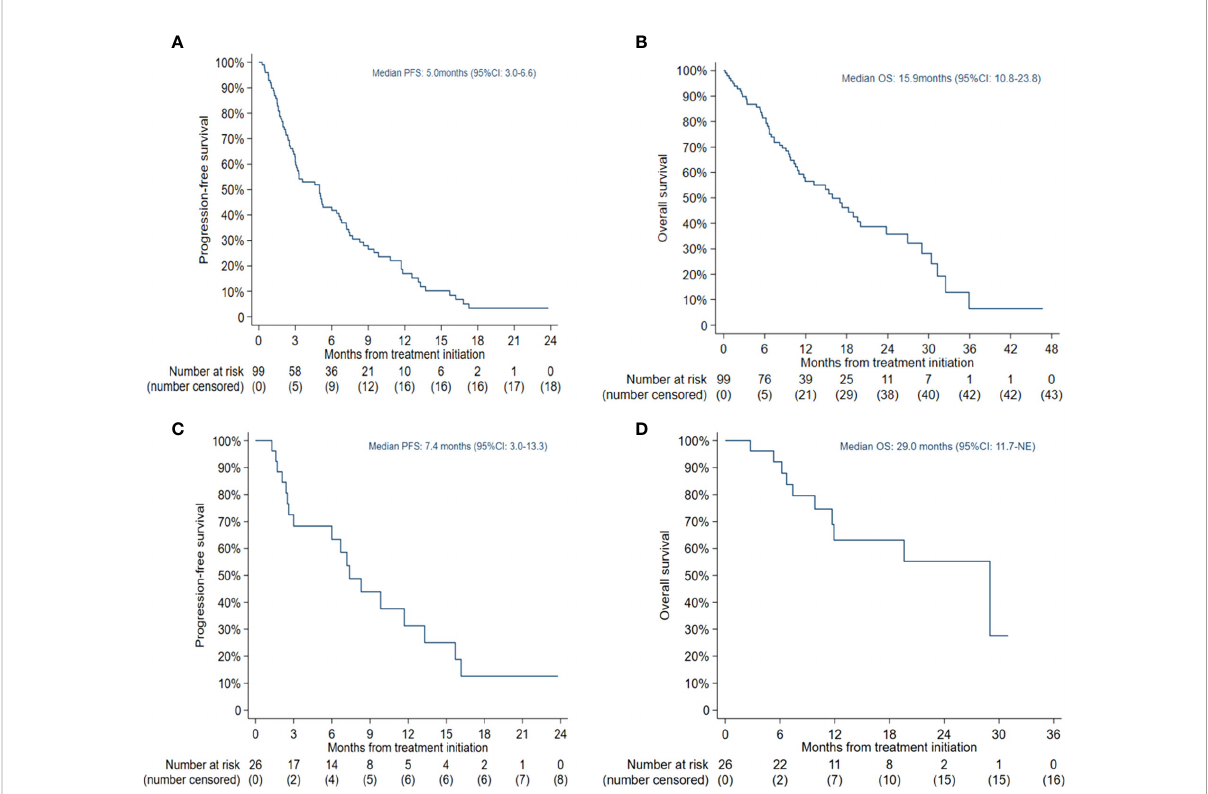
FIGURE 1 Kaplan-Meier estimates of progression-free survival (PFS) and overall survival (OS): (A) PFS in all patients; (B) OS in all patients; (C) PFS in patients receiving combination therapy with Eastern Cooperative Oncology Group (ECOG) score 0-1 and no more than 2 lines of prior therapy; (D) OS in patients receiving combination therapy with ECOG score 0-1 and no more than 2 lines of prior